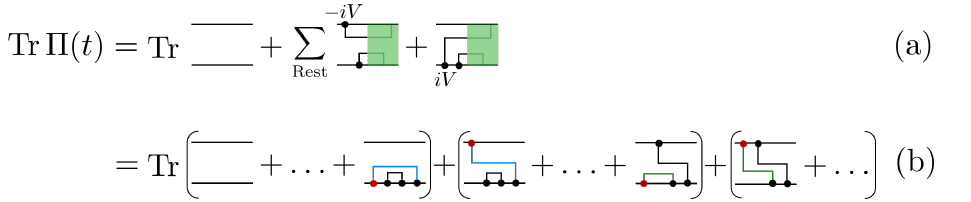
Figure 8: (a) Standard real-time expansion: trace preservation is guaranteed by the vertex flipping rule (22). (b) Reorganized expansion: Brackets indicate groups of diagrams that belong to the same physical process generated by one Keldysh operator k . Applying the simple rule of (a) reveals a nontrivial network of cancellations m between diagrams in different brackets corresponding to different Keldysh